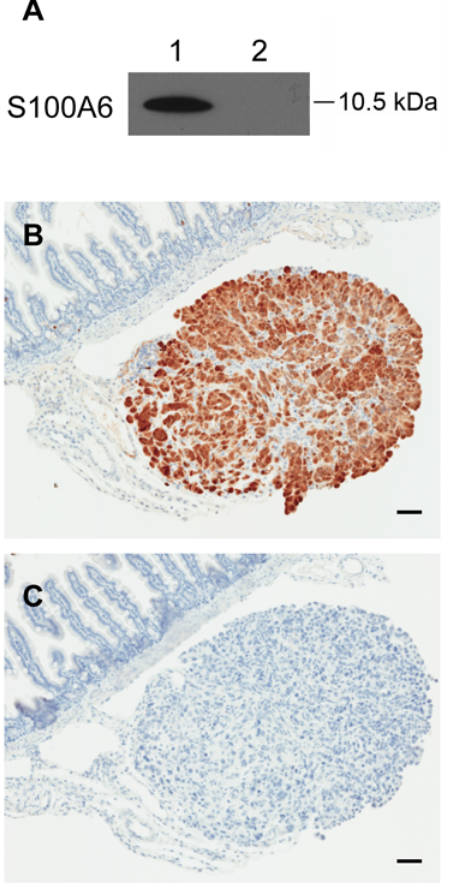
Figure 4. S100A6 protein expression in mouse serum and OVCA tissue. (A) Immunoblot analysis for the presence of S100A6 in pooled raw sera from cancer-bearing mice (1) and saline control mice (2). The sera were used in LMW protein fraction preparation for MS analysis in biomarker discovery. (B) OVCA xenografts express S100A6 as analyzed by IHC. Tumor xenograft implant on intestinal mesentery reveals S100A6 protein limited to tumor, with lack of immunolabeling in adjacent intestines and mesentery. (C) Serial section from tissue shown in B, used for IHC reaction control, reveals lack of immunoreactivity when primary S100A6 antibody is omitted from IHC. Immunoperox- idase, hematoxylin counterstain (Bars=50 m m).